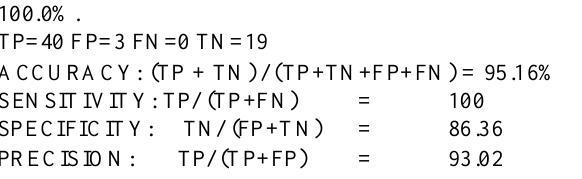
Figure 5. Confusion Matrix of Proposed Classification, using PLS for Classification True Positive Rate 86.4% and False Negative Rate yields 100.0%.